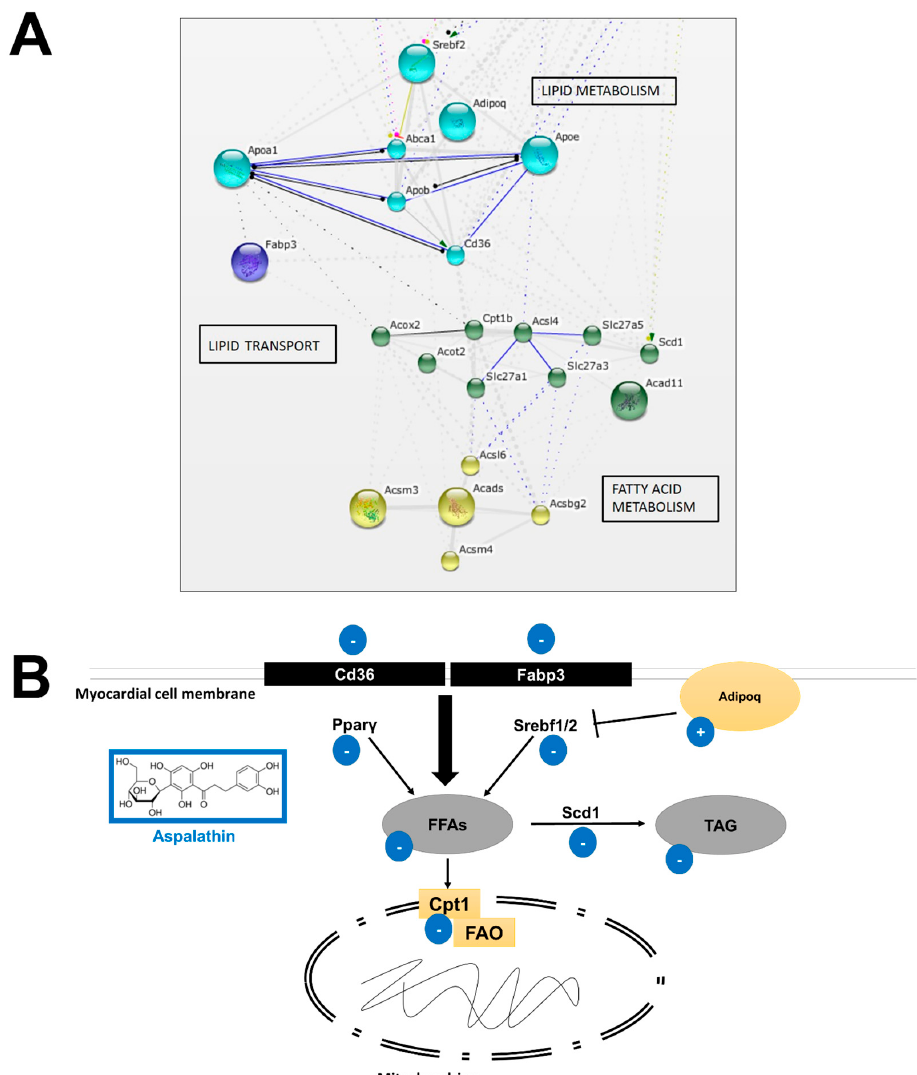
Figure 1. Aspalathin prevented high glucose-induced impaired cardiac substrate metabolism by reducing the uptake and oxidation of free fatty acids. ( A ) Search Tool for the Retrieval of Interacting Genes (STRING) database confirmed a strong interaction between aspalathin treatment and genes associated with lipid transport, lipid and fatty acid metabolism, relevant to dysregulation of intracellular lipid accumulation and fatty acid oxidation; ( B ) Representative diagram of the proposed modulating regulatory mechanisms of aspalathin against increased lipid accumulation and oxidation.